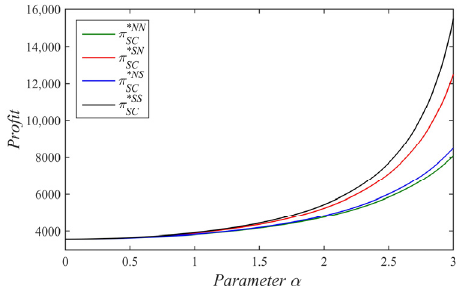
Figure 5. The impact of parameter α on the profits of supply chain.